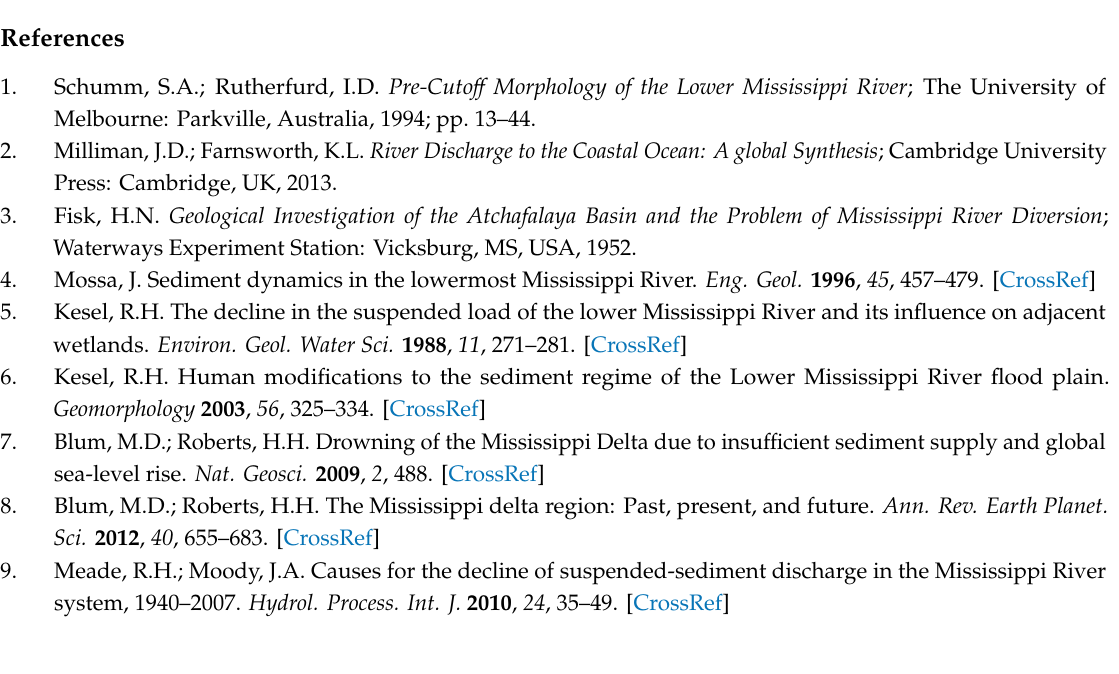
Figure S1: Temporal trends of lengths and